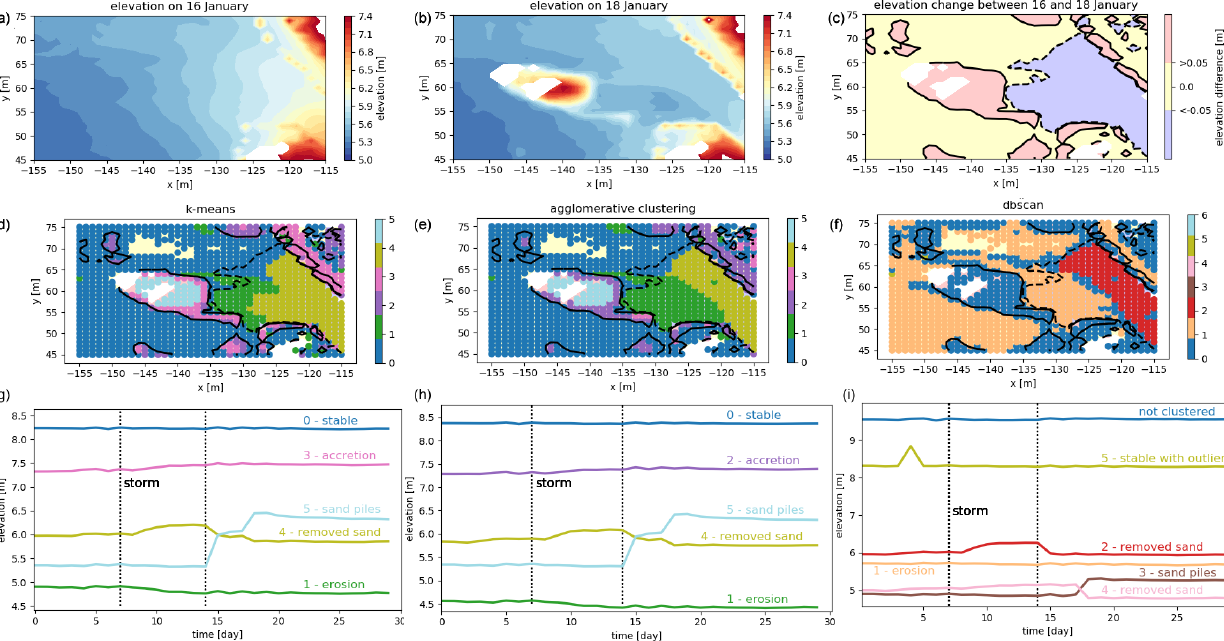
Figure 6. Test area for the comparison of clusters generated with three different algorithms. The test area is located where the northern access path meets the beach (see Fig. 1). (a–c) The elevation in the test area is shown on the day before the bulldozer accumulated a sand pile, when the entrance of the path was covered in sand (a) and after the bulldozer did its job (b) . Behind the sand pile, a gap appears in the data (in white), as the sand pile is obstructing the view for the laser scanner. To the right, we show the difference in elevation between 16 and 18 January from a significant level upwards (red) and downwards (blue) (c) . (d–f) Test area with significant changes in elevation (contour lines) and points clustered using the k -means algorithm (d) , agglomerative clustering (e) and the DBSCAN algorithm (f) . The colours of the clustered dots represent the clusters, as shown in Figs. 7, 8 and 9, respectively. (g–i) The corresponding mean time series for each of the relevant clusters are displayed below each of the plots (g, h, i) . The dotted lines mark the beginning and end of a stormy